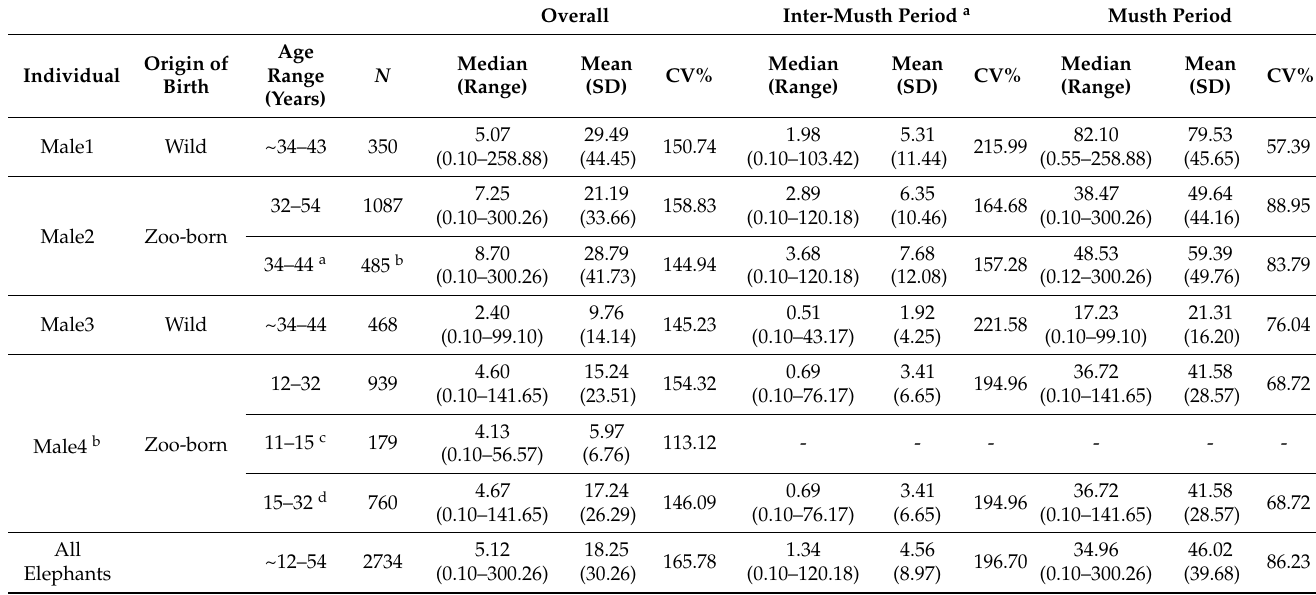
Table 6. Serum testosterone concentration (ng/mL) for males across all reproductive states and during periods of musth and inter-musth. Individual, birth origin, age range during study, number of samples measured for serum testosterone, concentration median, range, mean, standard deviation (SD), and coefficient of variation